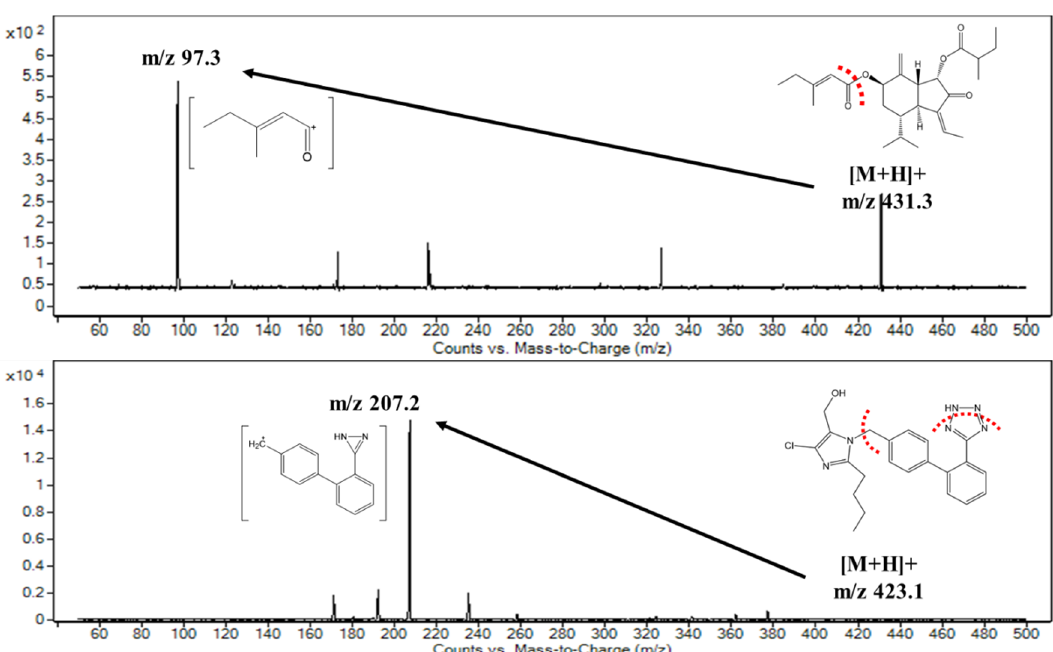
Figure 2. Proposed fragmentation patterns and tandem mass spectra of ECN and losartan (IS).